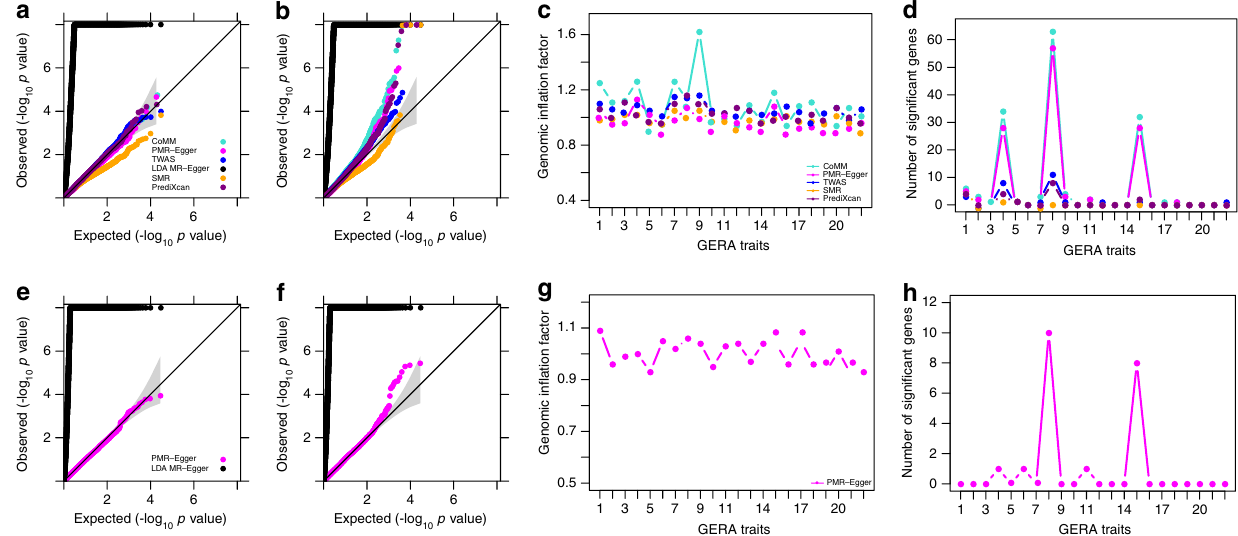
Fig. 5 TWAS analysis results by different methods for GERA traits. Compared methods include CoMM (turquoise), PMR-Egger (magenta), TWAS (blue), LDA MR-Egger (black), SMR (orange), and PrediXcan (purple). a Quantile – quantile plot of − log10 p -values from different methods for testing the causal effect for an exemplary trait irritable bowel syndrome. b Quantile – quantile plot of − log10 p -values from different methods for testing the causal effect for another exemplary trait asthma. c Genomic in fl ation factor for testing the causal effect for each of the 22 traits by different methods. d Number of causal genes identi fi ed for each of the 22 traits by different methods. e Quantile – quantile plot of − log10 p -values from different methods for testing the horizontal pleiotropic effect for an exemplary trait irritable bowel syndrome. f Quantile – quantile plot of − log10 p -values from different methods for testing the horizontal pleiotropic effect for another exemplary trait Asthma. g Genomic in fl ation factor for testing the horizontal pleiotropic effect for each of the 22 traits by different methods. h Number of genes identi fi ed to have signi fi cant horizontal pleiotropic effect for each of the 22 traits by different methods. For c , d , g , h , the number on the x axis represents 22 traits in order: asthma, allergic rhinitis, CARD, cancers, depressive disorder, dermatophytosis, T2D, dyslipidemia, HT, hemorrhoids, abdominal hernia, insomnia, iron de fi ciency, irritable bowel syndrome, macular degeneration, osteoarthritis, osteoporosis, PVD, peptic ulcer, psychiatric disorders, stress disorders, varicose